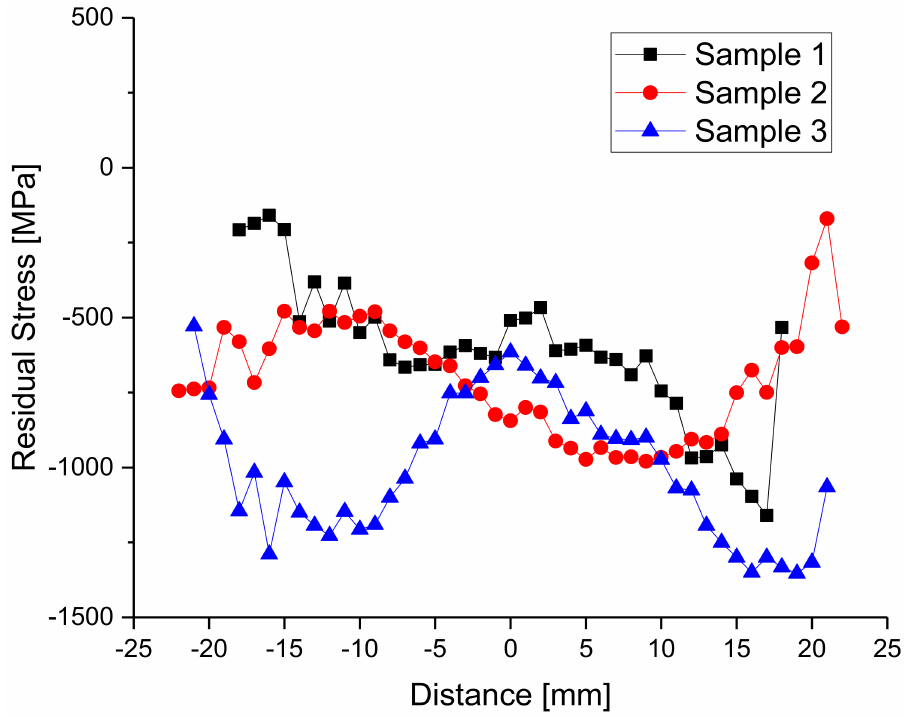
Figure 11. Results of measuring residual stresses from the head part of the rail samples. Compressive stress is displayed as a negative number on this graph, just as negative values are usually used to indicate compaction. In region A (range − 20 to − 5 mm), only sample 3 showed relatively high absolute values of residual stress. This was expected because trains with wheels directly contacting region A of the rail from which sample 3